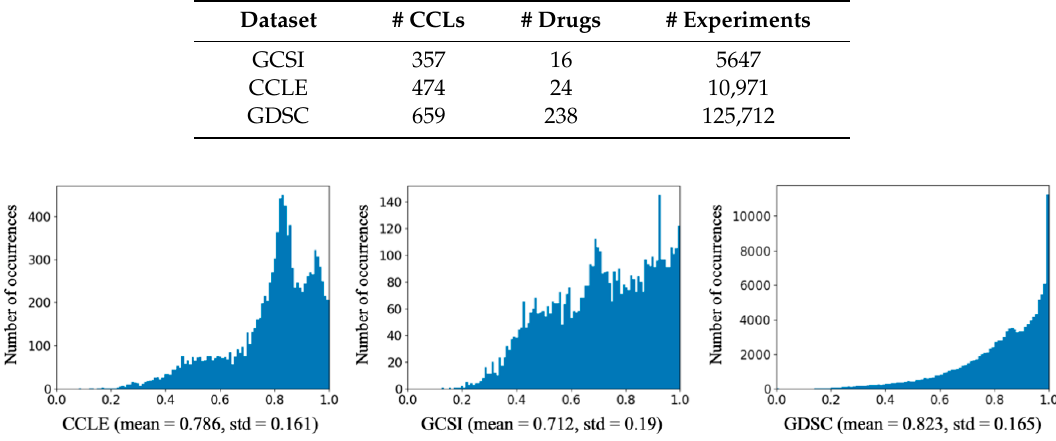
Figure 3. Histograms of drug response AUC values in datasets. Mean and standard deviation (std) of AUC values are shown under each histogram.